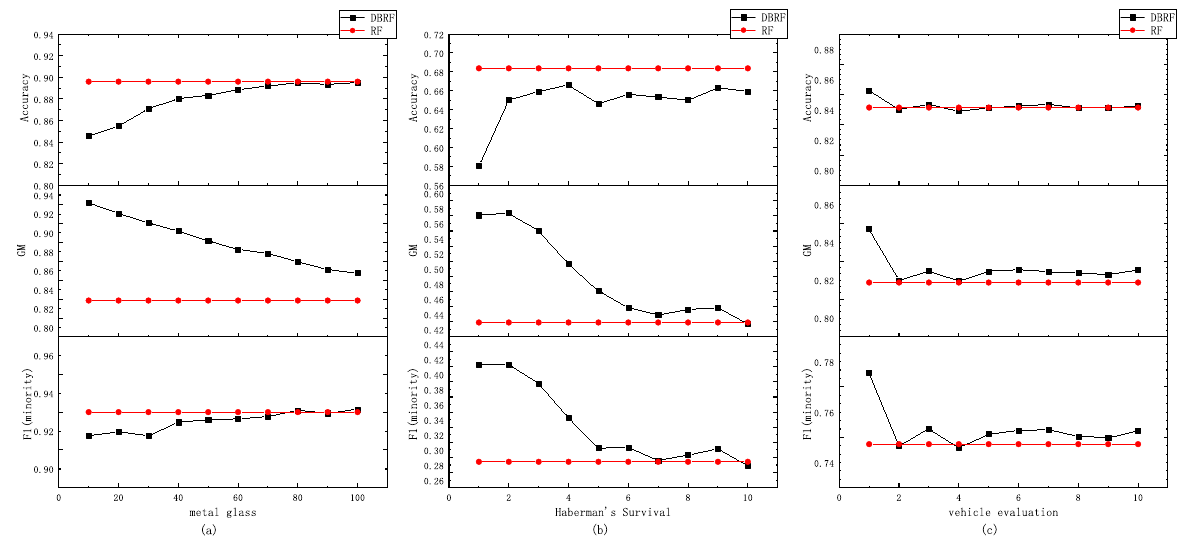
Figure 5. Three real-world datasets on ( a ) the metal glass, ( b ) Haberman’s survival, and ( c ) vehicle evaluation with different η . The horizontal axis is the η , and the vertical axis shows the F1, GM, and accuracy